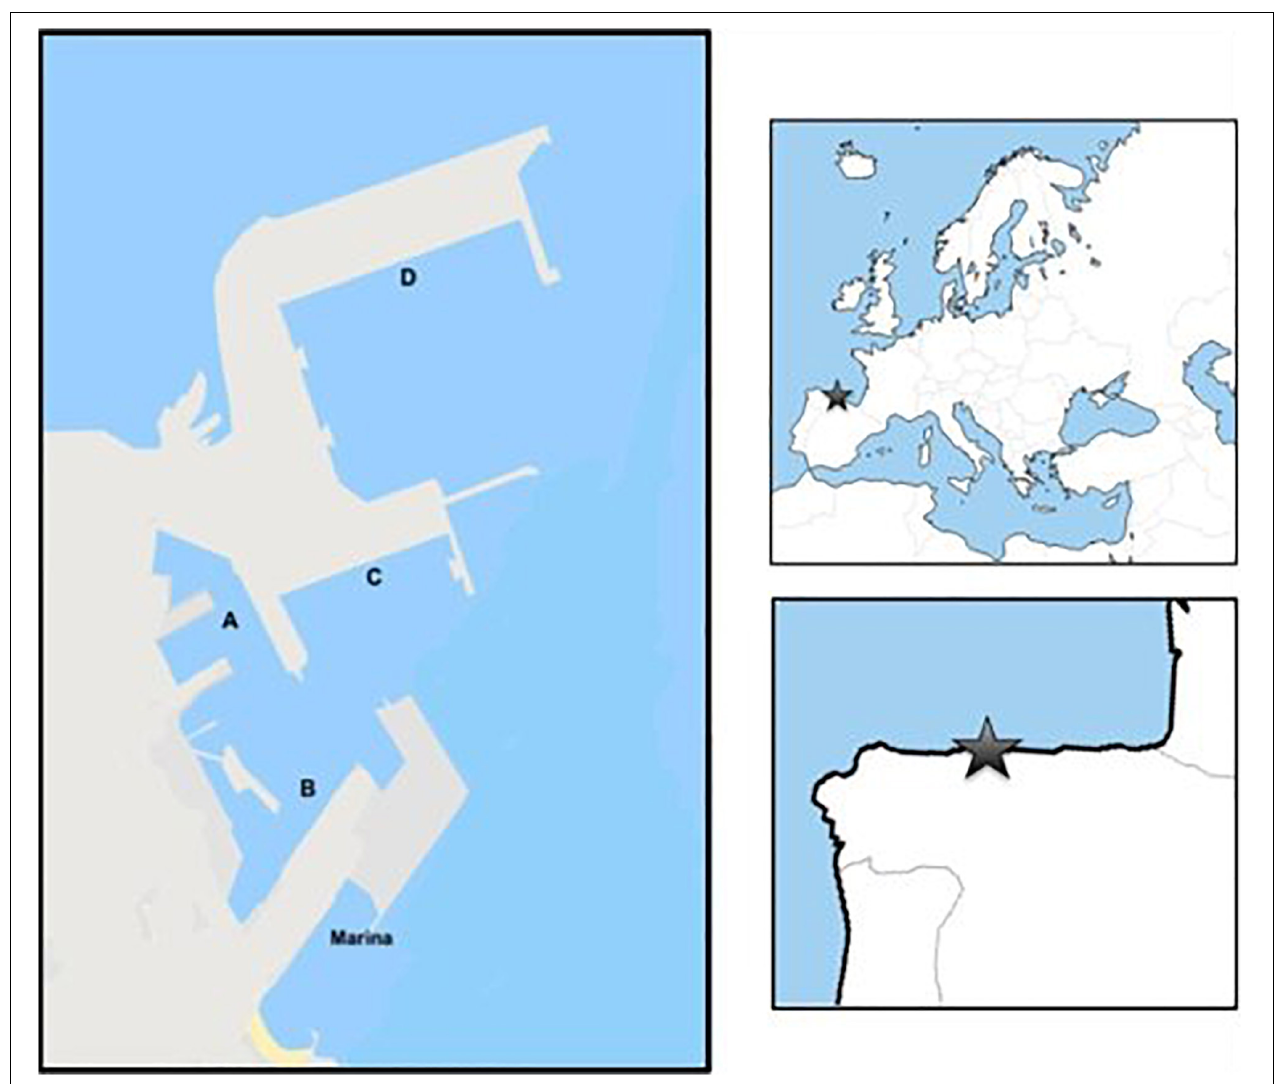
FIGURE 1 | Map of “El Muse1” international industrial port of Gijon, Bay of Biscay, Spain. (A–D) correspond to the different sampling areas inside the port divided by the type of traffic